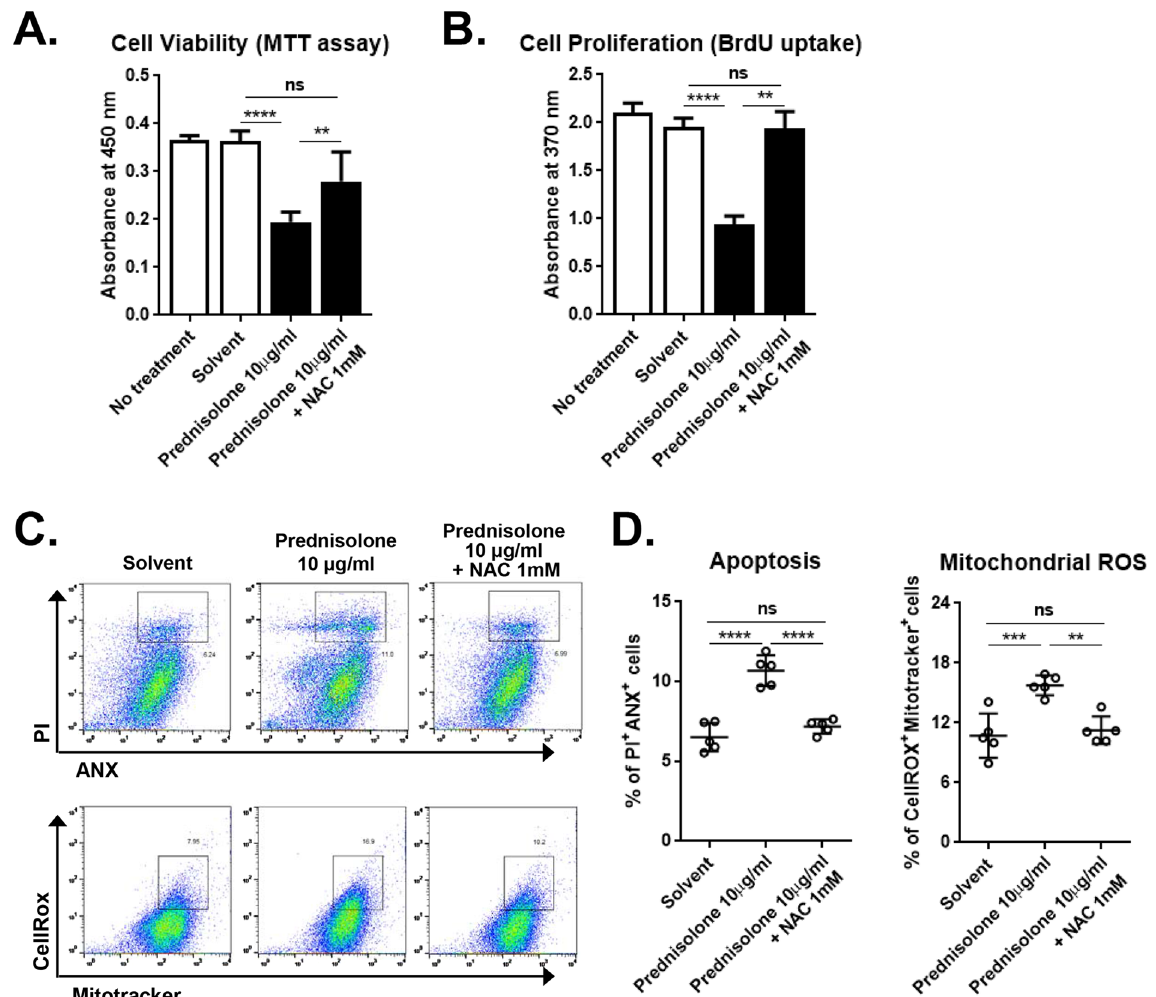
Figure 4. The mitochondrial ROS mediates the effects of prednisolone. ( A , B ) MTT and BrdU uptake assays in hCECs treated with 10 μ g/ml prednisolone in the presence or absence of N-acetylcysteine (NAC). ( C , D ) Representative and quantitative flow cytometry results for ANX + PI + cells and CellROX + MitoTracker + cells. Data are presented as mean ± SD from five independent experiments. ** p < 0.01, *** p < 0.001, **** p < 0.0001, ns: not